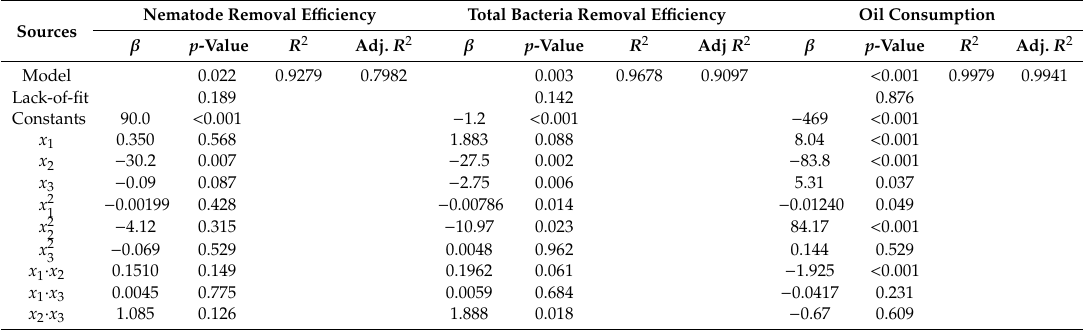
Table 3. Analysis of the models and regression coe ffi cients for the three response variables.